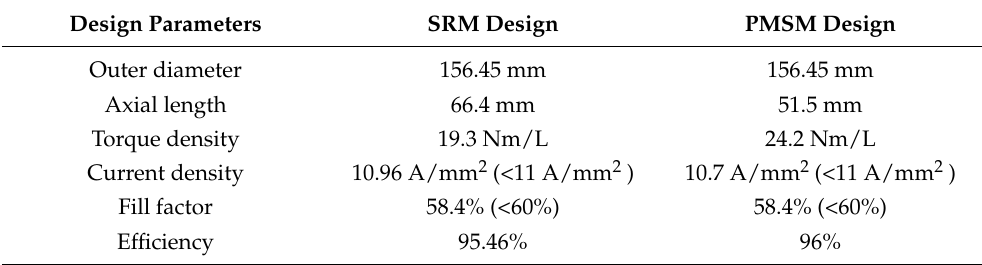
Table 7. Comparison of the SRM design with benchmark PMSM design.